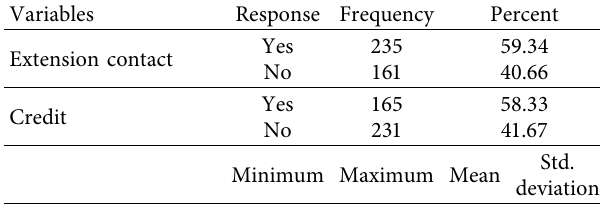
Table 4: Institutional characteristics of the sample